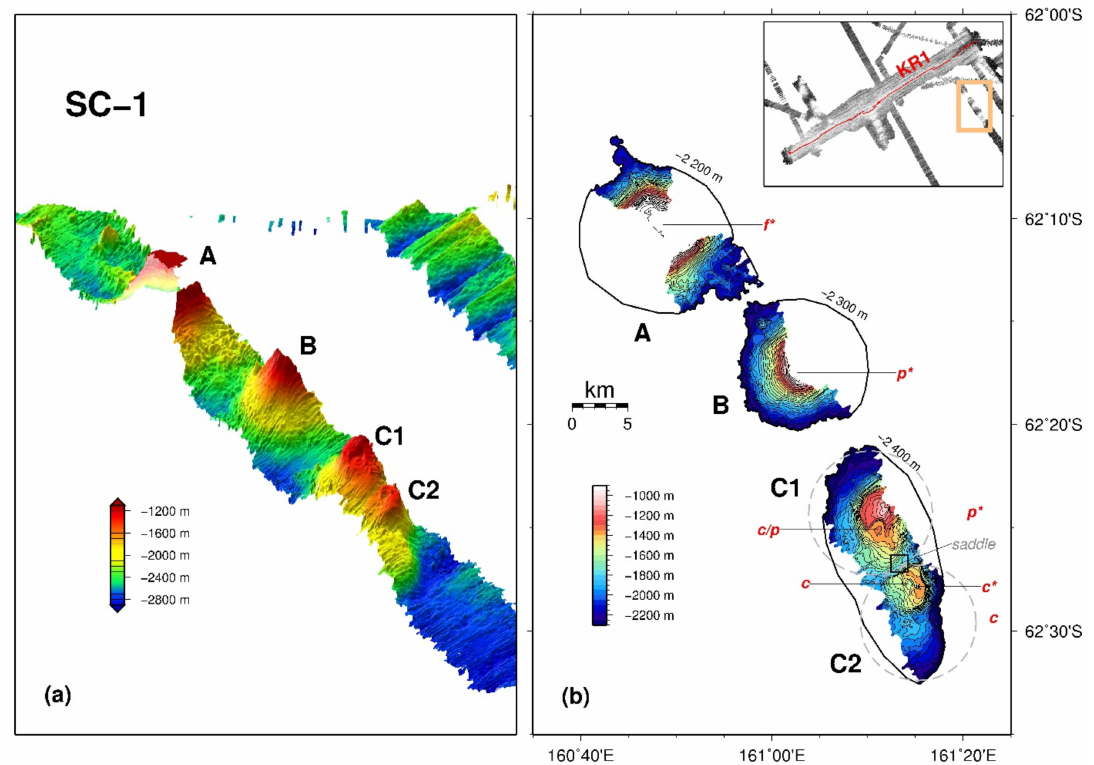
Figure 2. ( a ) 3-D perspective plot with 5 × vertical exaggeration for seamount chain SC-1; ( b ) the geomorphological structures of isolated volcanic edifices A, B, and C (=C1 + C2) at their respective reference depths (i.e., 2200 m for seamount A; 2300 m for B; 2400 m for C), based on 50 m contoured multi-beam bathymetric data. Summit types for each seamount are marked with red letters: c = crater/caldera; p = peak; f = flat top. The letters with asterisks indicate the representative summit for each seamount.